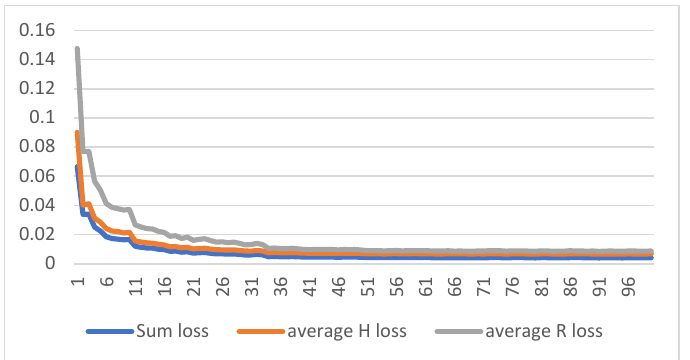
Figure 5. Loss of network 𝐻 , network 𝑅 , and the total loss of these two networks in the deep neural network with different iterations of training.